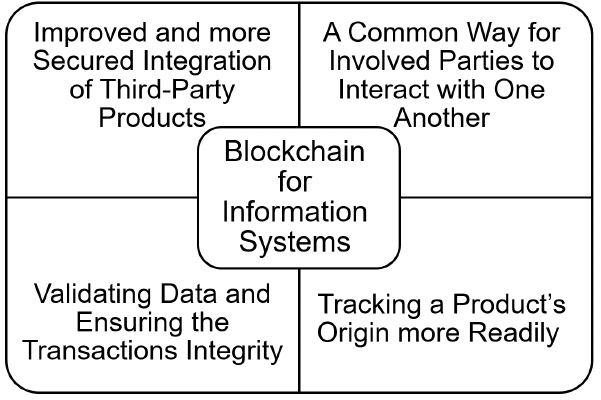
Figure 5. Blockchain for information